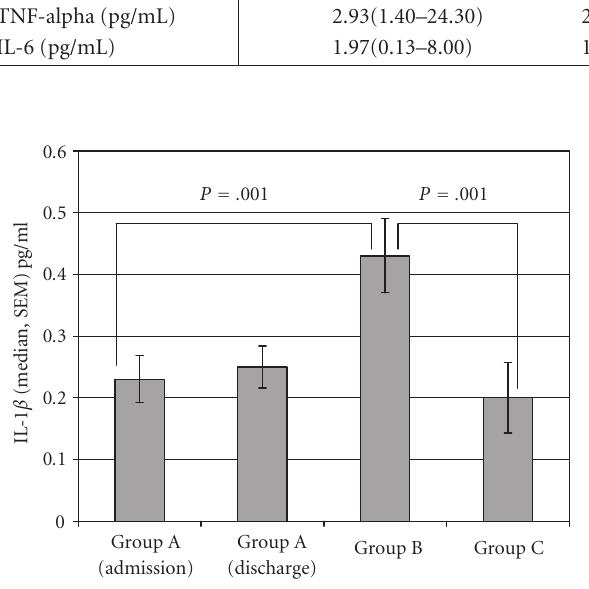
Figure 2: Serum levels (median, SEM) of TNF-alpha in the three study